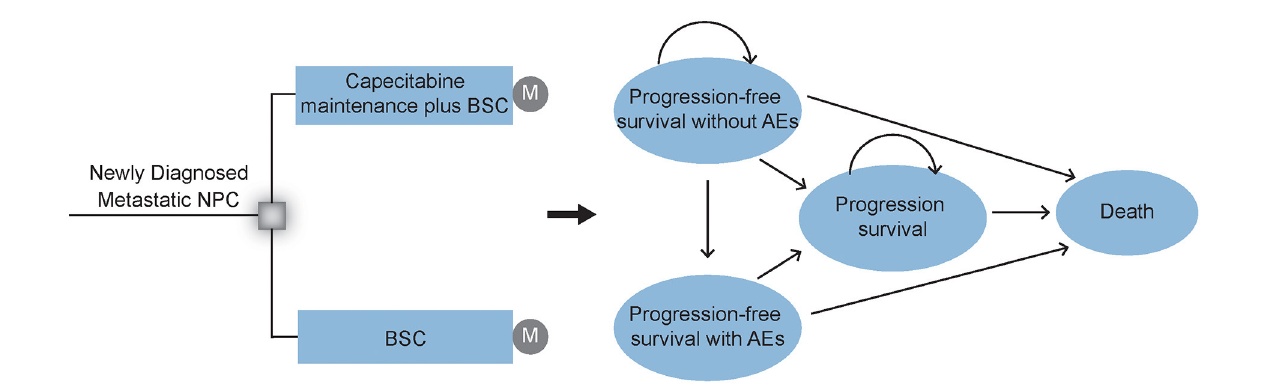
FIGURE1 Markov model structure. Markov model structure and Markov states are used to evaluating the economic and health outcomes of CBSC and BSC groups as a first-line treatment after induction chemotherapy for patients with mNPC. After initial treatment, patients could experience a response with or without AEs, or experience the disease progression until death. NPC, nasopharyngeal carcinoma; CBSC, Capecitabine maintenance therapy plus best supported care group; BSC, best supported care; AEs, adverse